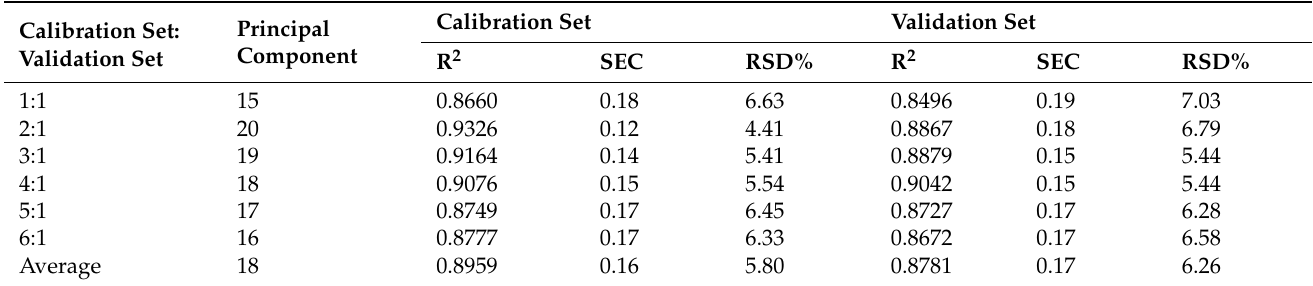
Table 5. NIR prediction results of the model for different samples (Tyr).